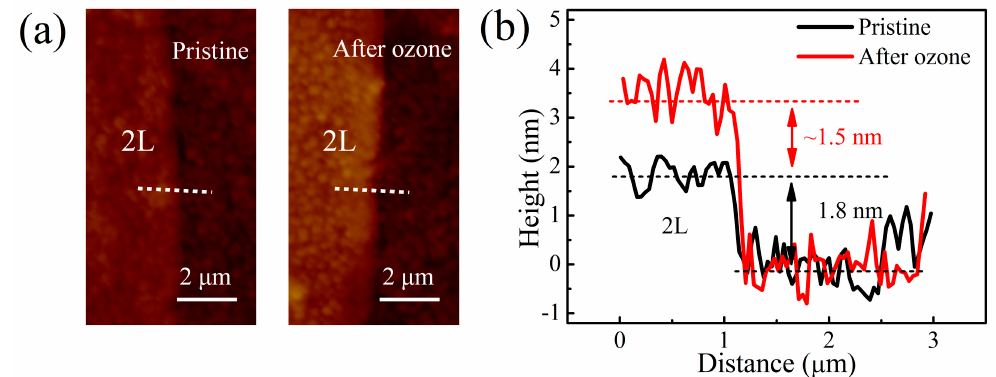
Figure 4. ( a ) AFM images of 2L MoTe 2 flake squared in Figure 1a at pristine state (left) and after O 3 treatment (right). ( b ) AFM height profiles of pristine (black line) and oxidized (red line) 2L MoTe 2 along the white dashed lines in (a).